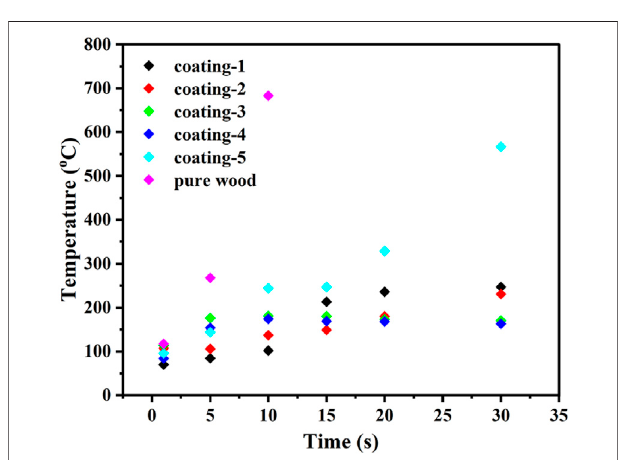
Frontiers in Materials |